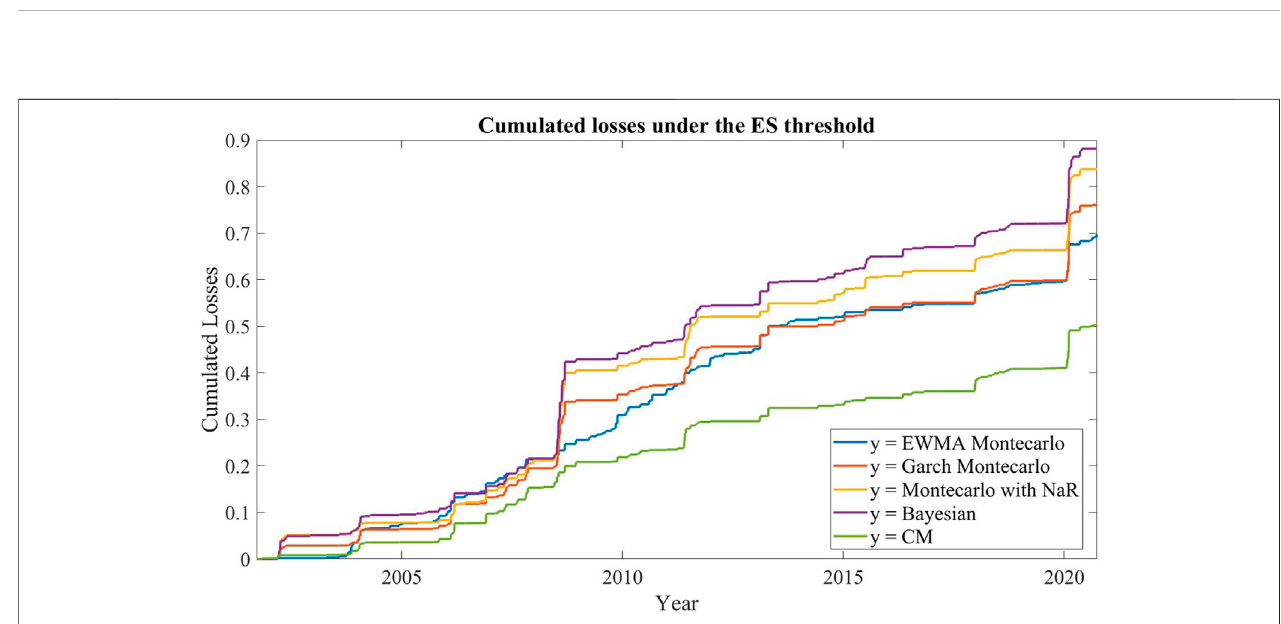
FIGURE 2 | Cumulated losses below the ES